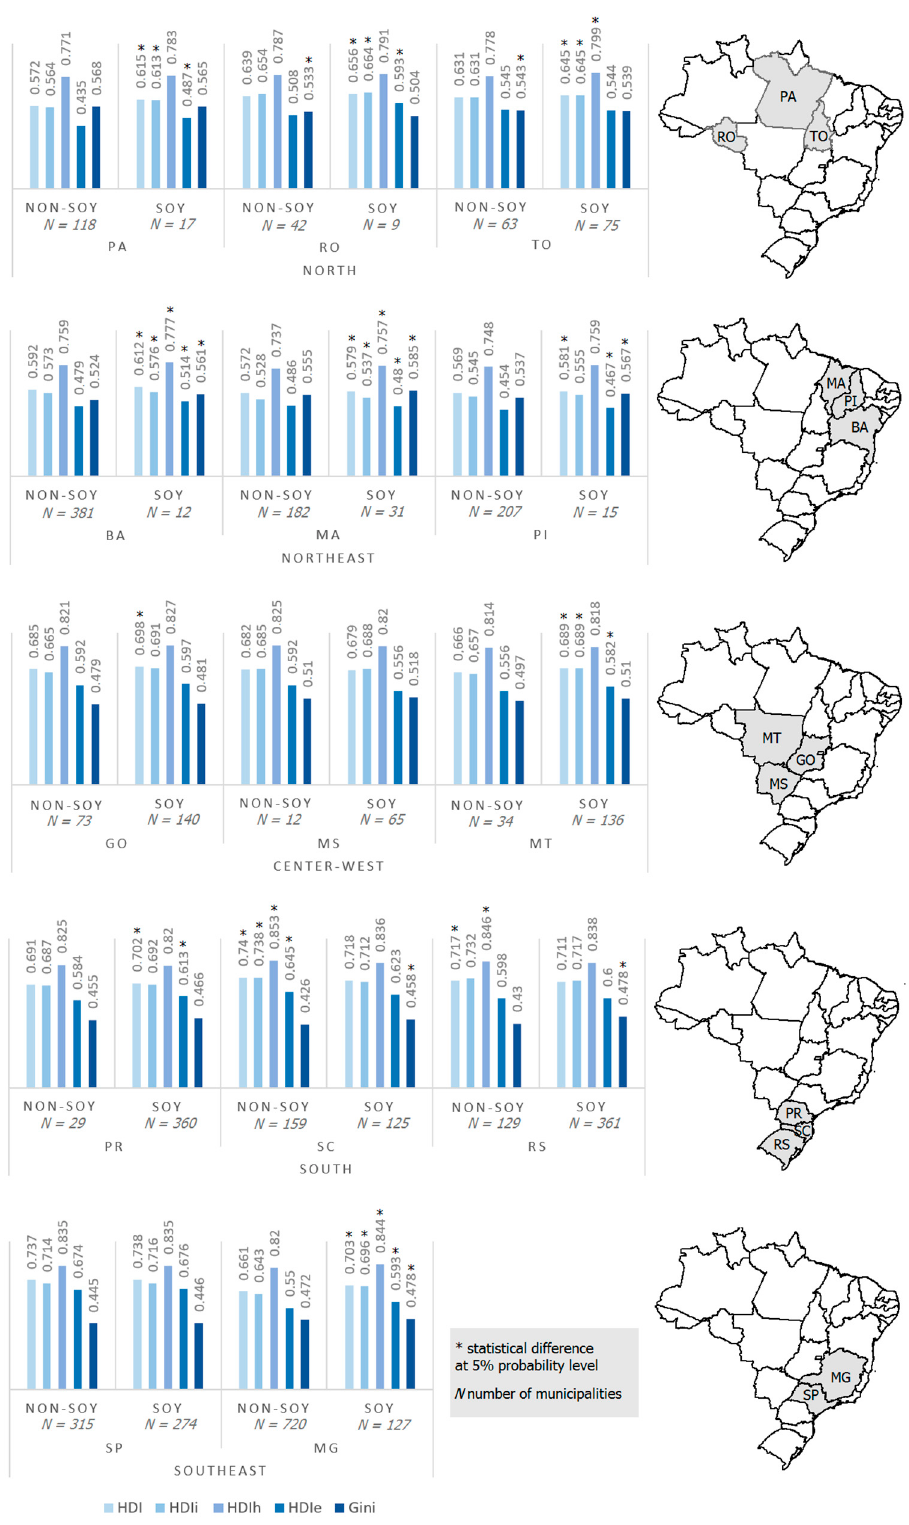
Figure 4. Human Development Index (HDI), its three components, and the income Gini coefficient for income in Brazilian states grouped by the national geographic regions: North, Northeast, Center-West, Southeast and South (* denotes statistical difference at 5% of probability level).